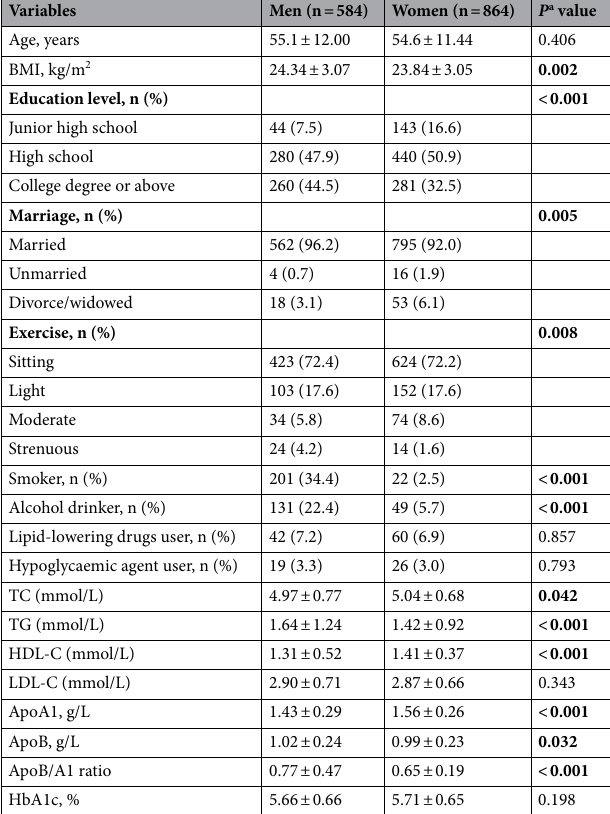
Table 1. The baseline characteristics of the study participants. Apo Apolipoprotein, BMI body mass index, HbA1c Glycated haemoglobin, HDL-C high density lipoprotein cholesterol, LDL-C low density lipoprotein cholesterol, TC total cholesterol, TG triglycerides. a P values were calculated by Student’s t test for the continuous variables and Chi-square test for categorical variables. Significant values are in